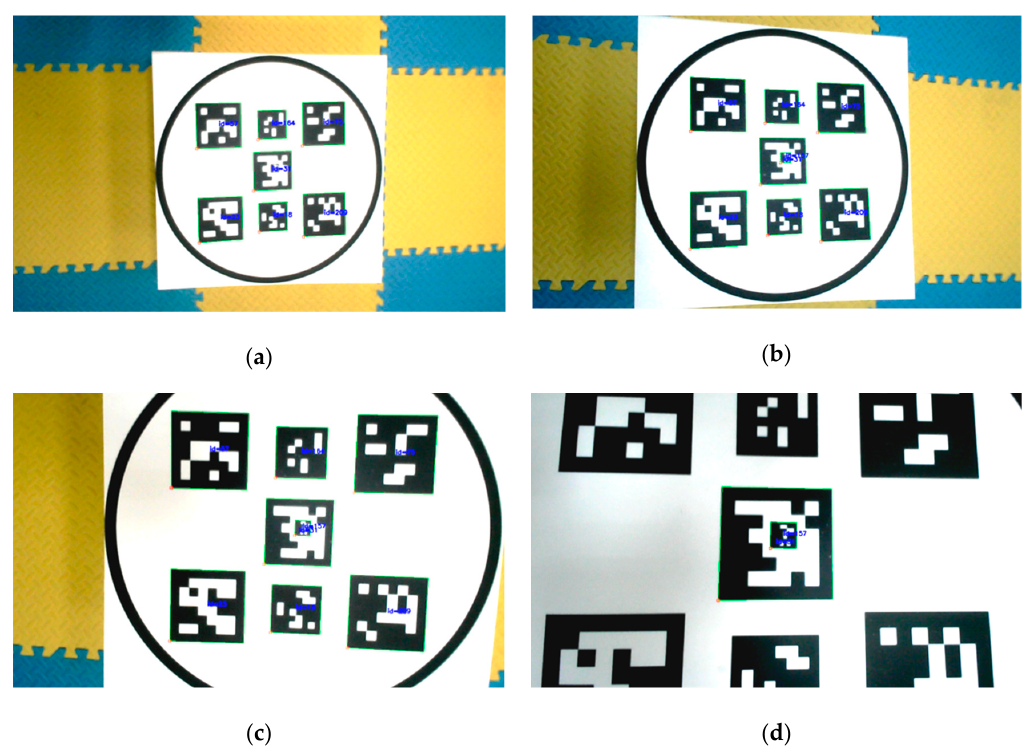
Figure 2. Markers recognized at di ff erent heights in camera view. When the camera is far away from the landing pad, the whole circle is captured in the view ( a , b ). With the change of attitude and height during a landing maneuver, part of the pattern moves out of the camera view ( c ). When the camera gets very close to the landing pad, only two markers can be recognized ( d ).